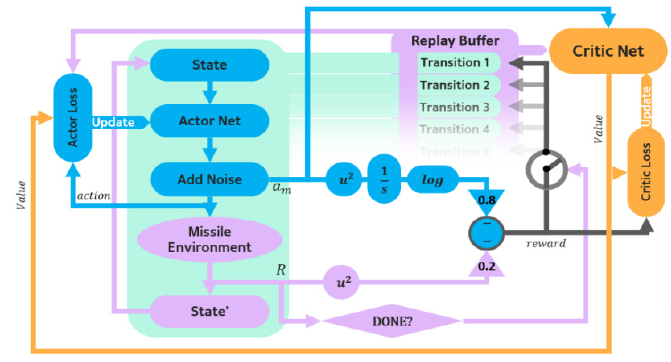
Figure 6. Structure of the training algorithm.